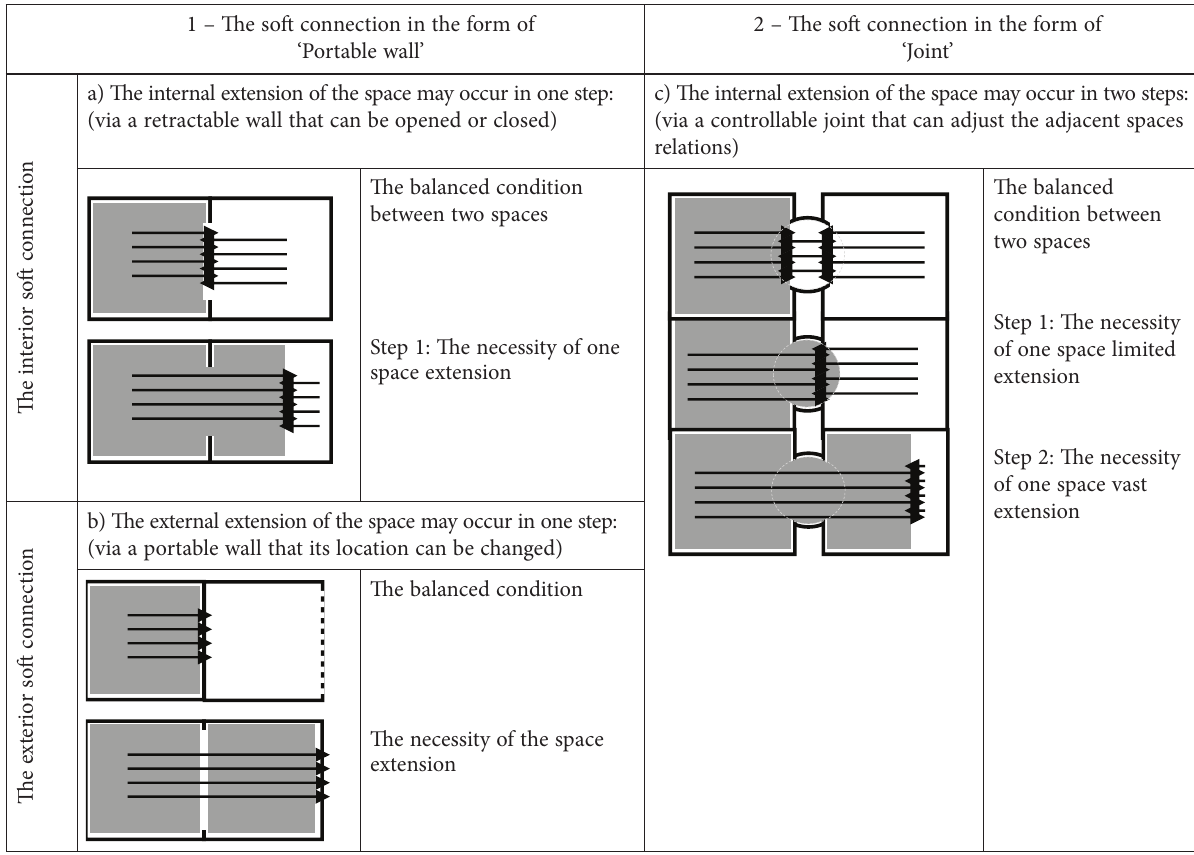
Table 2. Different types of the soft connection ‘Portable